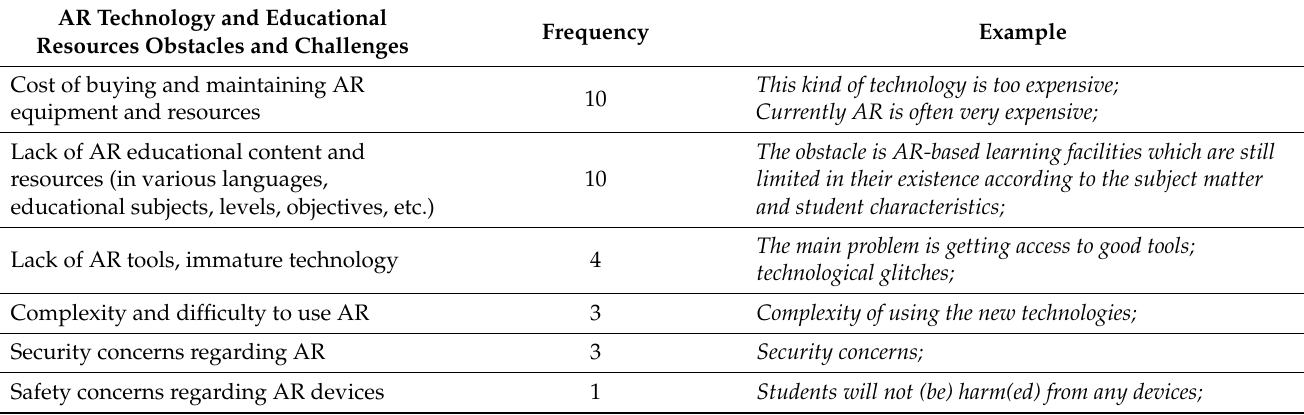
Table 12. AR technology and educational resources obstacles and challenges in integrating ARinE.